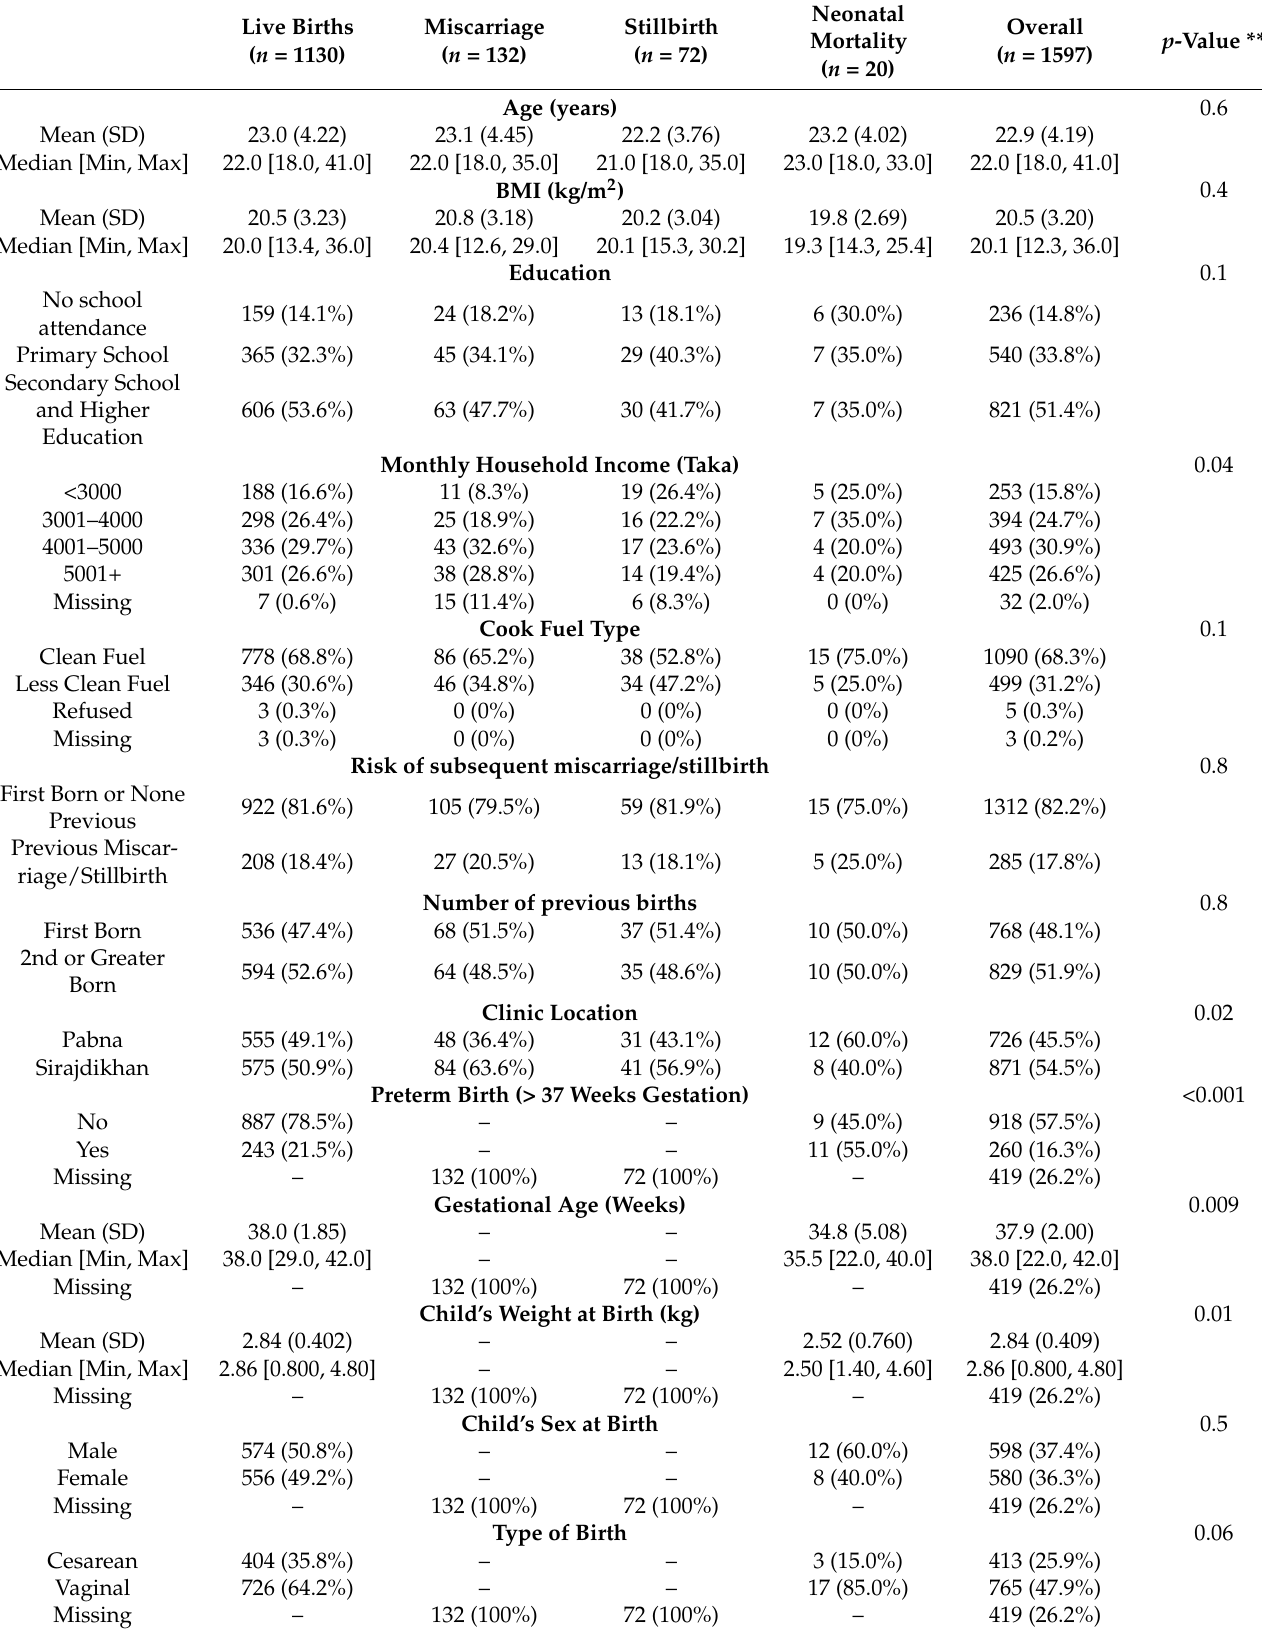
Table 1. Characteristics of Bangladesh Cohort by Adverse Pregnancy Outcome ( n =